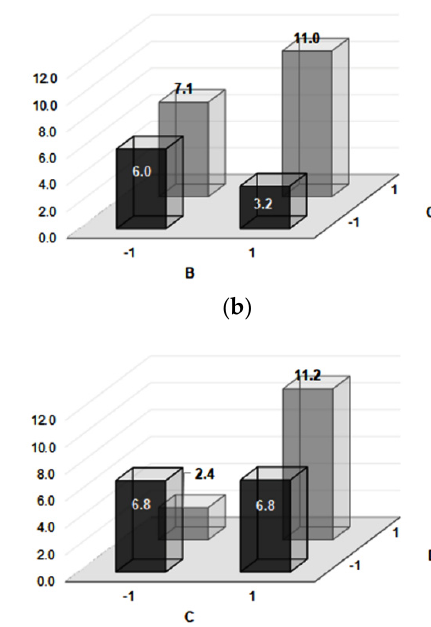
Figure 10. Representation on a normal probability plot of the factors with a significant effect on the response to impact. A(destabilisation temperature); B(cooling media); C(tempering tempera ‐ ture); D(tempering time).